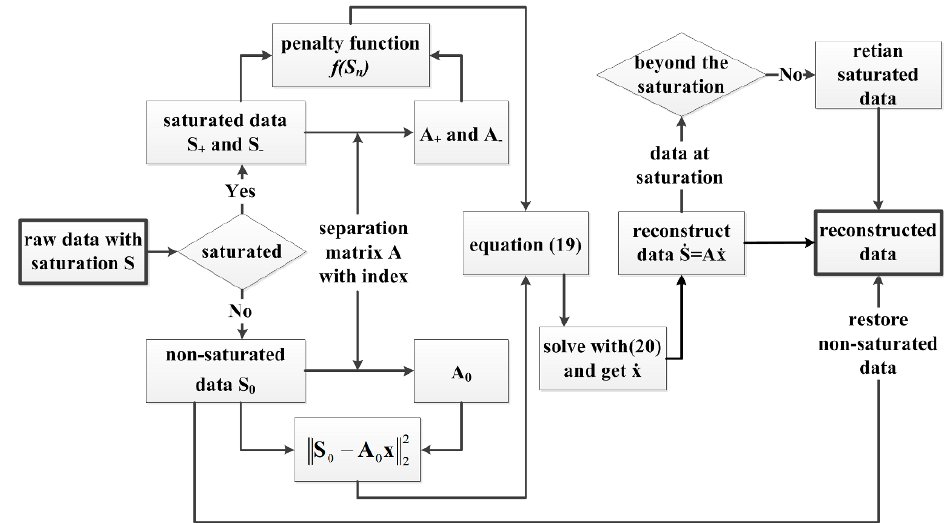
Figure 13. Workflow of the proposed method.